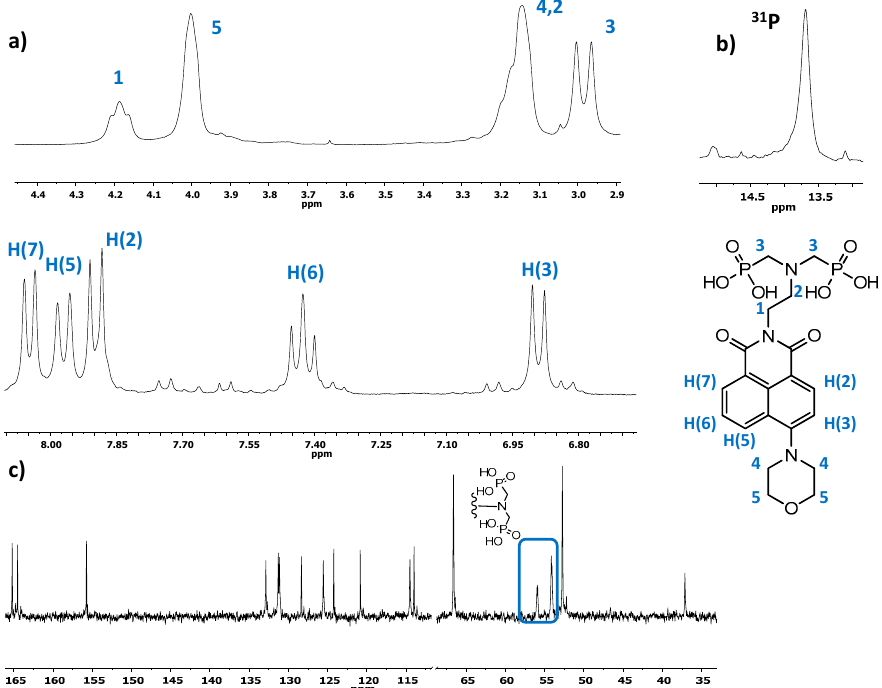
Figure 2. 1 H ( a ), 31 P ( b ) and 13 C ( c ) NMR spectra of ADMP-F in DMSO-d 6 . 1 H NMR (D 2 O, pH = 8.0, 300.28 MHz, t = 25.0 °C): 2.94 (d, 4H, J = 11.61, C H 2 PO 3 H), 3.04–3.20 (m, 6H, C H 2 N(CH 2 PO 3 H) 2